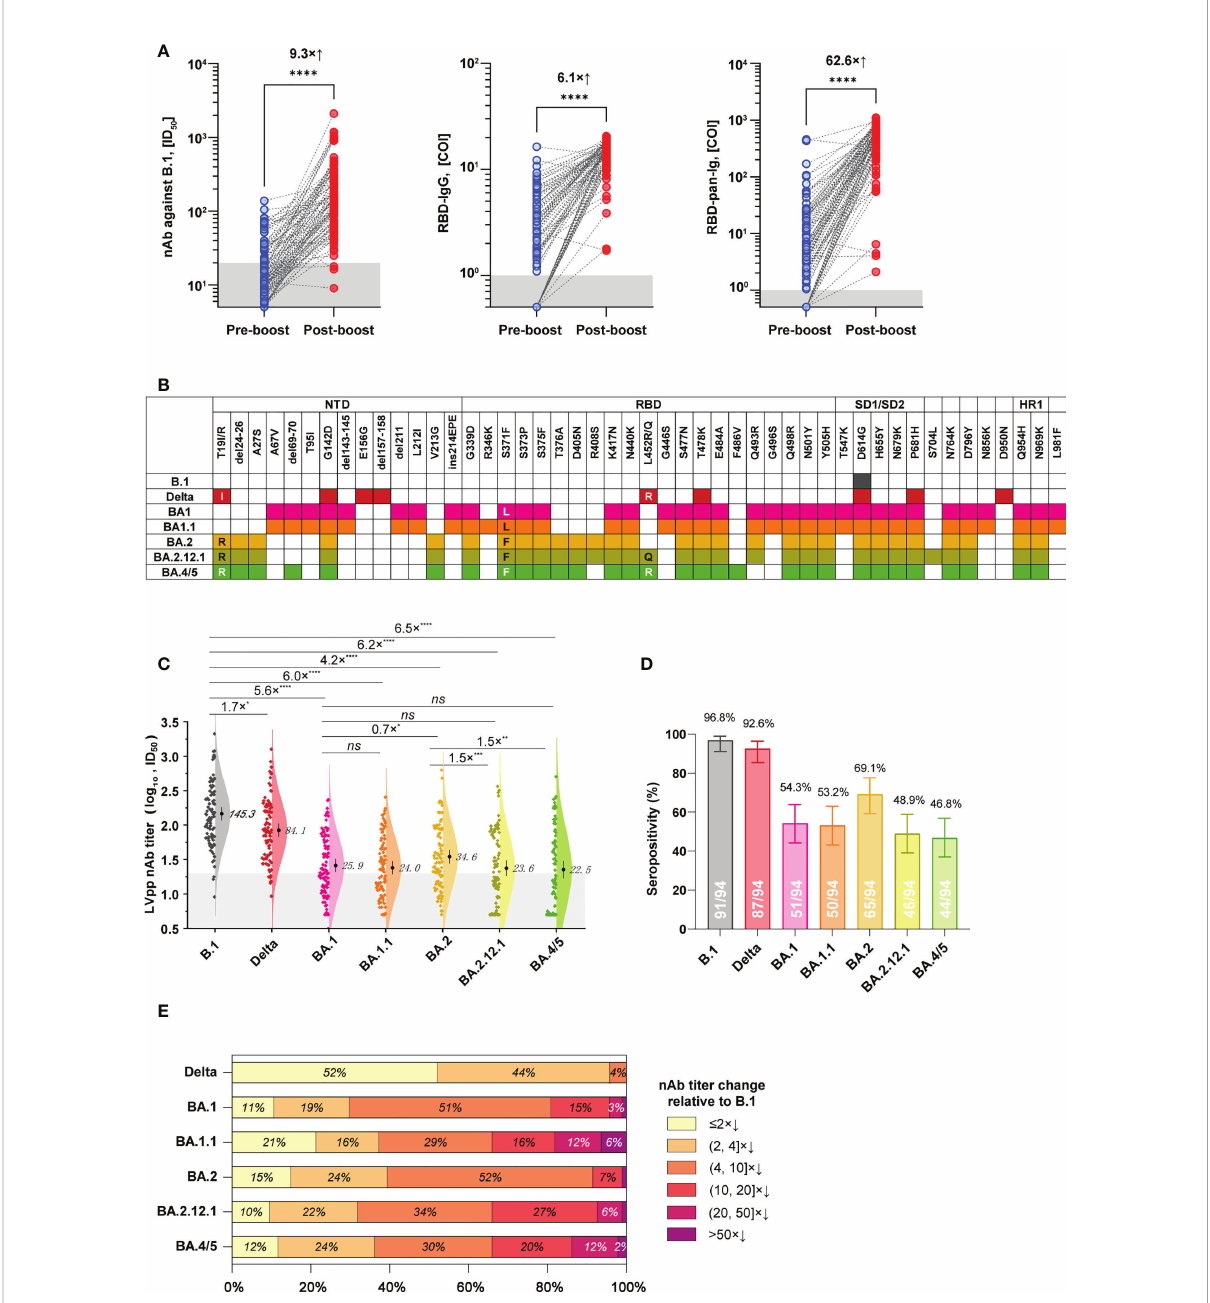
FIGURE 3 Cross-neutralization pro fi les of plasma samples from a subgroup in the 3-dose group against various spike variants. (A) The levels of nAb (against B.1, left panel), RBD-IgG (middle panel), and RBD-pan-Ig (right panel) in paired samples of the same donor were collected before and after the booster immunization. Dark shadows indicate the LODs. (B) Schematics of mutations presented in spikes of the B.1, Delta variant, and different Omicron sub-lineages. Colorized frames indicate the mutation presence at the corresponding amino-acid position. (C) Comparisons of the neutralizing activities of plasmas against the ancestral B.1 and different variants. The numbers show the nAb GMT against various viruses. The dark shadow indicates the LOD. (D) Seropositive percentages of these plasmas in neutralizing pseudoviruses bearing different spike variants. (E) Proportions of plasmas according to the strata of nAb decrease relative to B.1. COI, cutoff index; ID 50 , half-maximal inhibitory dilution; NTD, N- terminal domain; RBD, receptor binding site; SD1/SD2, subdomain 1/2; HR1, heptad repeat 1; *p<0.05; **p<0.01; ***p<0.001; ****p<0.0001; ns, not signi fi cant (p>0.05). The combination of an “ x ” with an up arrow represents the folds of the relative increase in antibody, while the combination of an “ x ” with a down arrow indicates the opposite meaning, the folds of the relative decrease in